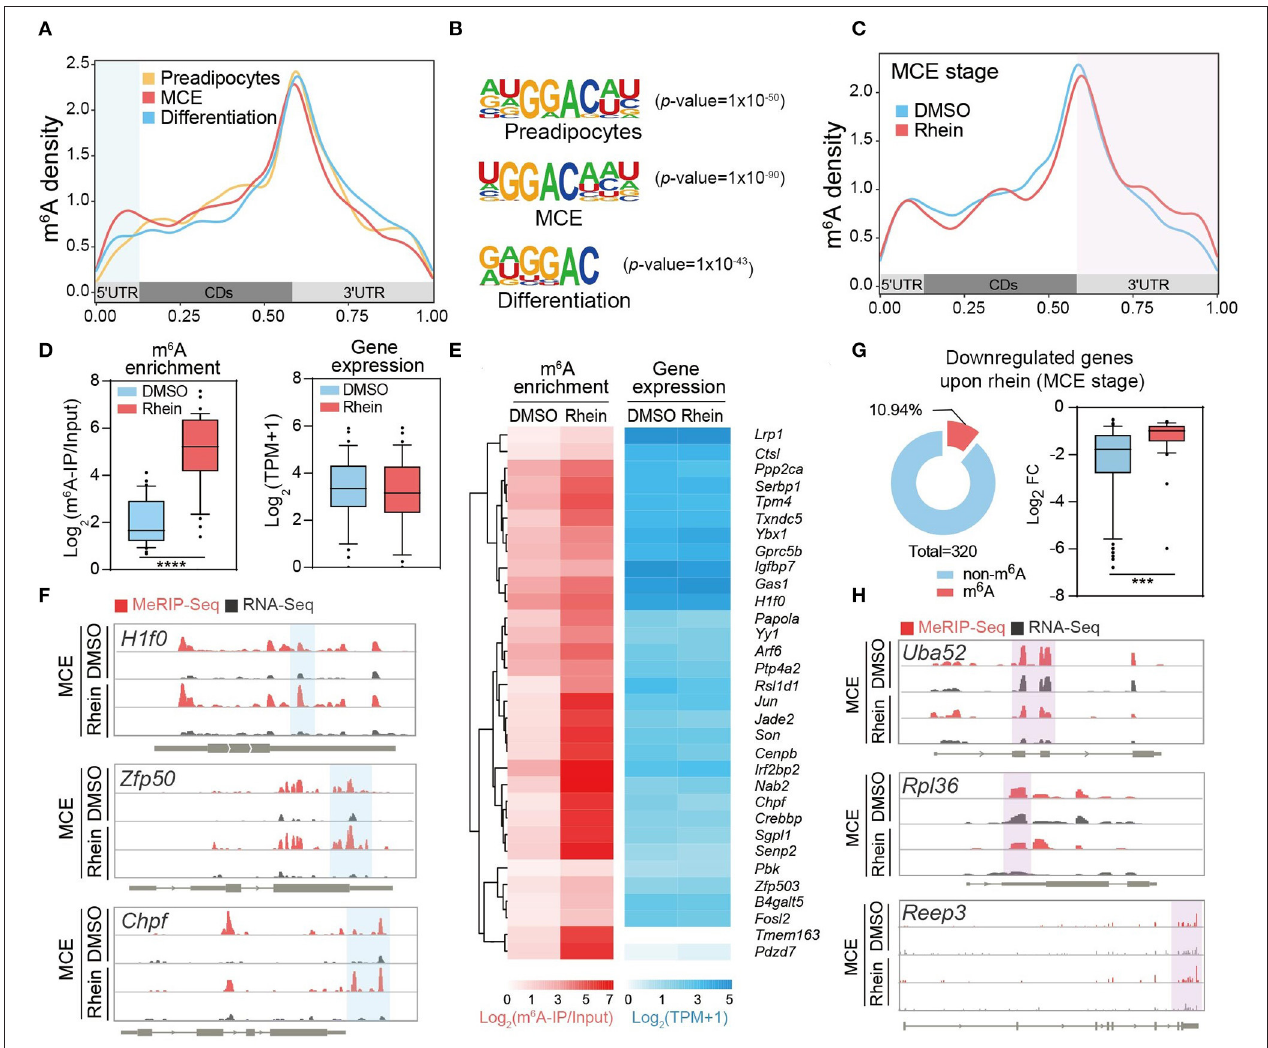
FIGURE 4 | Rhein rearranges the landscape of N 6 -methyladenosine (m 6 A) methylome. (A) Metagene profiles of m 6 A distribution across the transcriptome of cells at the preadipocytes, the MCE stage, or the differentiation stage, respectively. (B) Sequence logo representing the consensus motif relative to m 6 A at the various stages in response to rhein or DMSO, respectively. (C) Metagene profiles of m 6 A distribution across the transcriptome of cells treated with DMSO or rhein at the MCE stage. (D) Box plot showing the fold changes of m 6 A enrichment and RNA levels in genes with elevated m 6 A levels (fold change > 2) upon rhein treatment. (E) Heatmap showing m 6 A enrichment and expression levels of genes with increased m 6 A at the MCE stage upon rhein treatment. (F) Examples of rhein-regulated m 6 A peaks. In an Integrative Genomics Viewer (IGV) format, normalized m 6 A-IP and input control coverage are shown in red and gray, respectively. Exons are represented by thick black boxes; 5 ′ and 3 ′ untranslated regions (UTRs) are represented by thin black boxes; introns are represented by thin lines. (G) Ring chart showing the ratio of m 6 A-modified transcripts in genes downregulated by rhein at the MCE stage. Box plot showing the fold changes of RNA levels in genes (fold change > 2) downregulated by rhein treatment. (H) Examples of m 6 A-independent transcriptional downregulation. In an IGV format, normalized m 6 A-IP and input control coverage are shown in red and gray, respectively. Exons are represented by thick black boxes; 5 ′ and 3 ′ UTRs that are represented by thin black boxes; introns are represented by thin lines. *** p < 0.001, **** p < 0.0001.